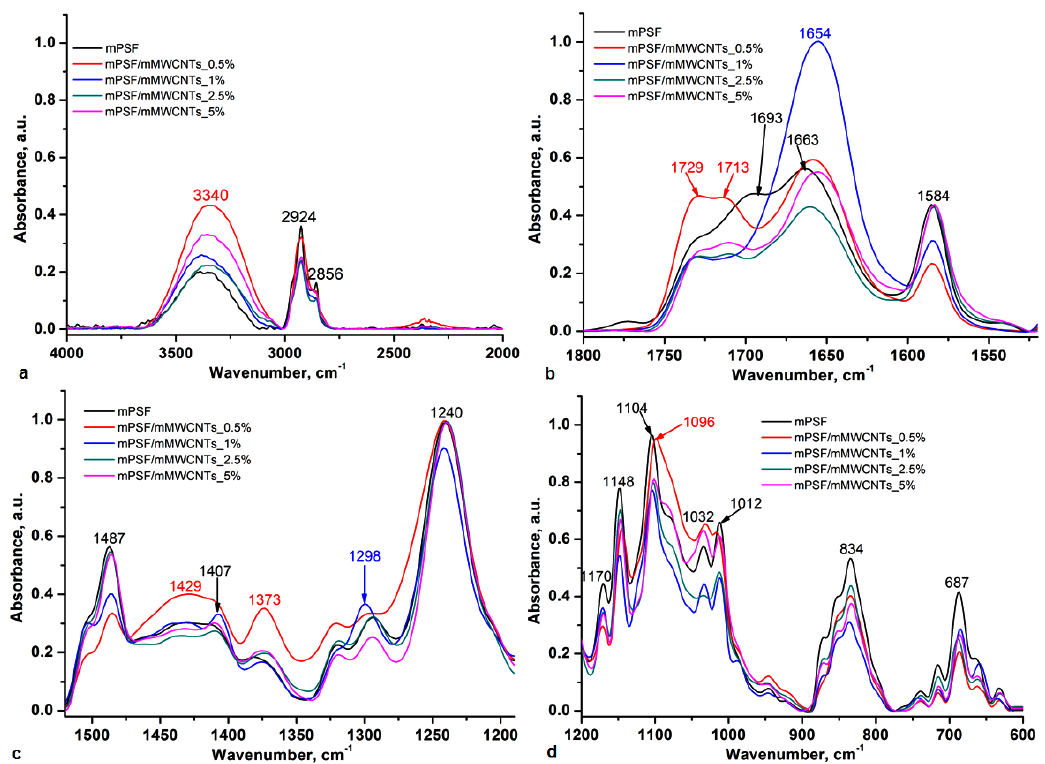
Figure 4. ATR–FTIR spectra of mPSF and mPSF–based composite system in the 4000–2000 cm − 1 ( a ), 1800–1500 cm − 1 ( b ), 1600–1200 cm − 1 ( c ), and 1200–600 cm − 1 ( d ) spectral ranges. In the 1500 − 600 cm ‒ 1 range, the mPSF/mMWCNTs composites have very similar ab- sorption bands: 1487 cm ‒ 1 (O-H deformation vibration coupled with C-O and C-H wag- ging vibration), 1429 cm ‒ 1 and 1407 cm ‒ 1 (C-C stretching in aromatic rings), 1373 cm ‒ 1 (C-SO 2 -C asymmetric stretching), 1298 cm ‒ 1 (S-O stretching), 1240 cm ‒ 1 (C-O-C sym- metric stretching) (Figure 4c), 1148 cm ‒ 1 (C-SO 2 -C symmetric stretching), 1104 cm ‒ 1 , 1096 cm ‒ 1 , 1032 cm ‒ 1 , 1012 cm ‒ 1 , and 834 cm ‒ 1 (aliphatic C-O-C, aromatic C-H bending and rocking), 750–650 cm ‒ 1 (C-H out-of-plane deformation vibrations) (Figure 4d), proving that after embedding the mMWCNTs in the matrix, the chemical structure of the mPSF did not change [60]. The differences in composition of the PVA and mPSF matrices before and after em- bedding of mMWCNTs were highlighted by using the method of IR spectral subtraction of the spectra, and the results are indicated in Figure 5. In this case, the resulting subtrac- tion spectrum will correspond to the difference between the spectrum of the initial matrix and the spectrum of the composites. Spectra were processed by using Bruker OPUS 6.5 software. It can be seen that the main differences between the initial matrix and compo- sites consist of the characteristic bands of O-H groups (O-H stretching at about 3300 cm ‒ 1 and 1643 cm ‒ 1 , O-H deformation vibration at 1510 cm ‒ 1 , 1306 cm ‒ 1 , 930 cm ‒ 1 , and 814 cm ‒ 1 ) (Figure 5).